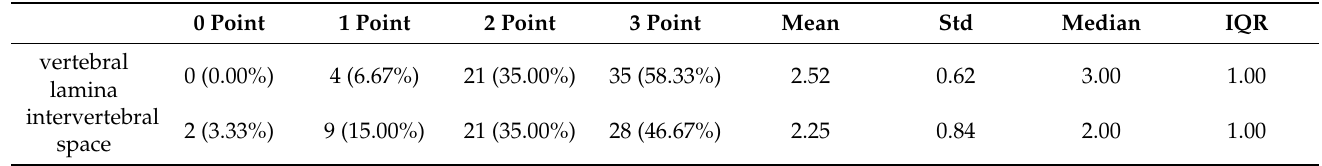
Table 2. Ultrasound Visibility Score of Neuraxial